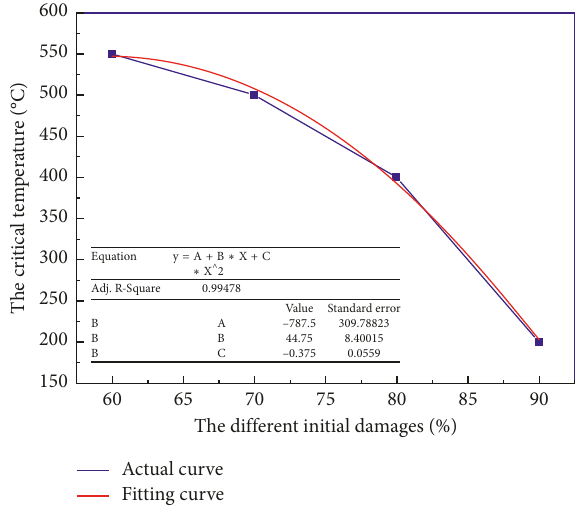
Figure 8: Critical temperature as a function of initial